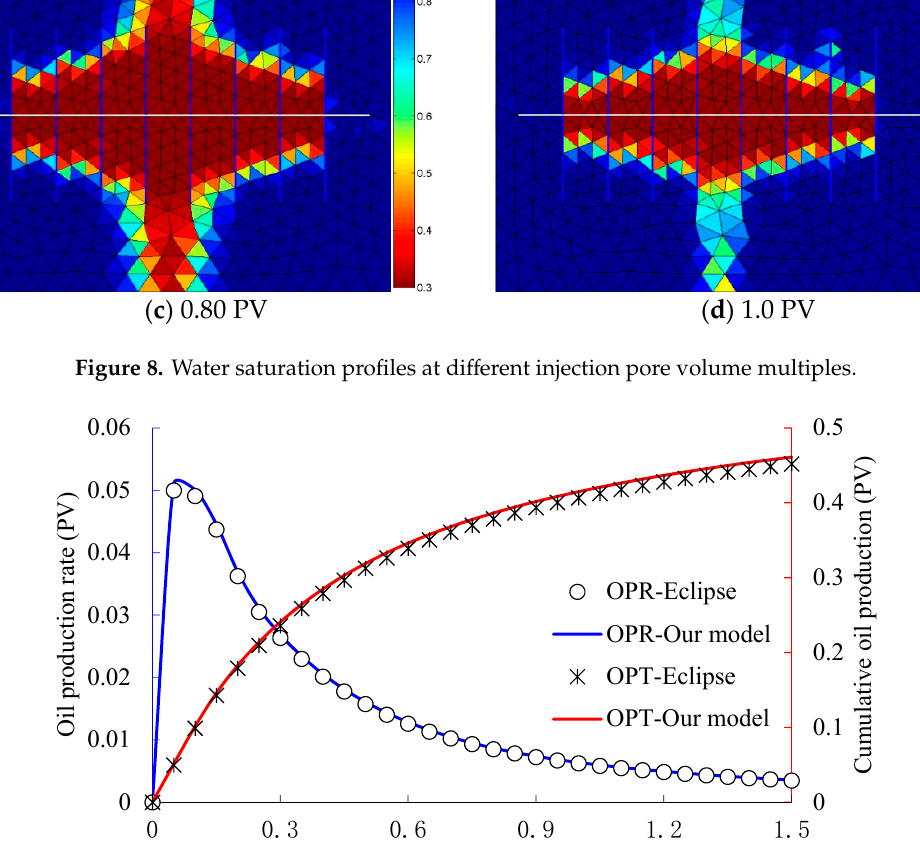
Figure 9. Oil production performance of staged fractured horizontal well.